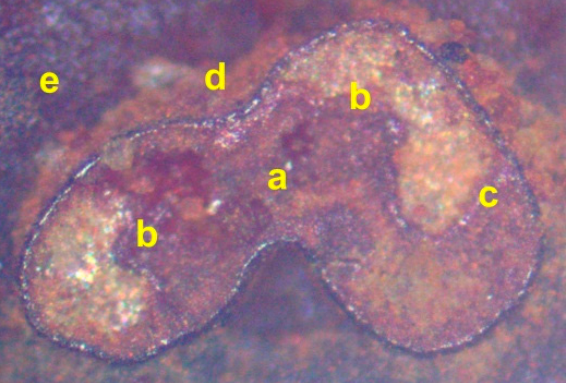
Figure 14. Trial ST1e [16] ZVI desalination pellet following desalination. ( a ) = authigenic oolitic goethite nodule; ( b , c ) = adsorbed oolitic goethite nodules containing authigenic cuboid Fe 0 crystallites (1 to 5 microns in diameter) crystallizing within the goethite. The Fe 0 crystallites vary in color from white to blue to yellow to pink (depending on orientation), are cuboid, isotropic, and have a reflectance of about 60%. Sub-nodule ( c ) includes a rim of (FeO (wustite) with exsolved Fe 0 crystals) separating it from the main goethite (FeO(OH)) mass of the nodule; ( d ) = iron rich boundary of the nodule (FeO (wustite) with exsolved Fe 0 crystals) and the associated active outer growth fringe (light brown) of the oolitic nodule. ( e ) = goethite matrix (dark). Reflected light. Field of view = 0.173 mm; ZVI:water ratio = 21.72 g/L; Feed water salinity = 8.22 g/L; Product water salinity after 230 days = 2.24 g/L. NaCl removed = 5.98 g/L (0.28 g/g ZVI). Feed water pH = 6.24; Product water pH = 8.42.